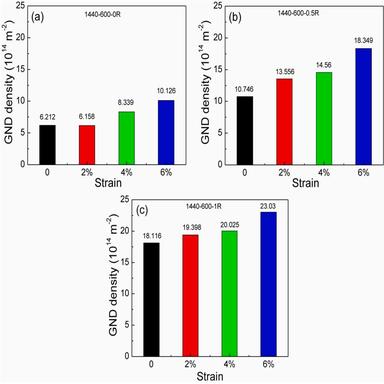
GNDs versus tensile strain of 1440–600 sample at (a) r = 0 R, (b) r = 0.5 R, (c) r = 1.0 R.